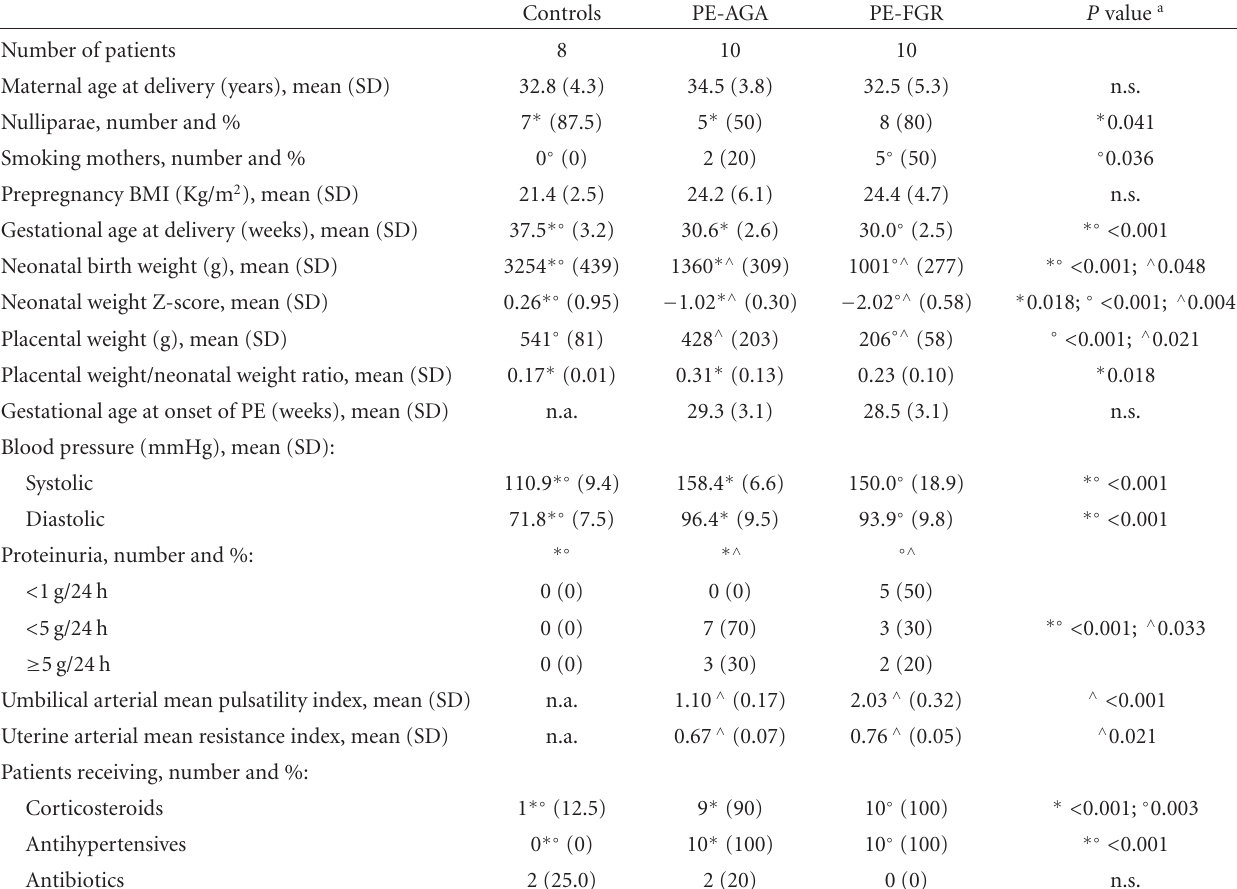
Table 1: Clinical characteristics of control and pathological pregnancies.